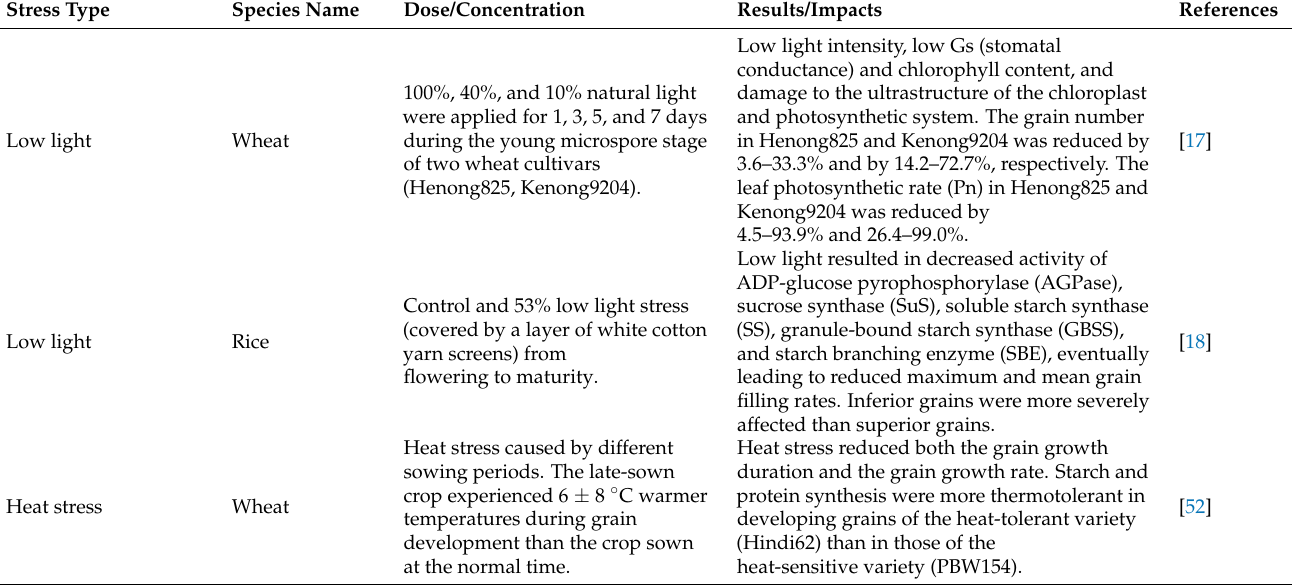
Table 1. Cereal responses to environmental stimuli during grain